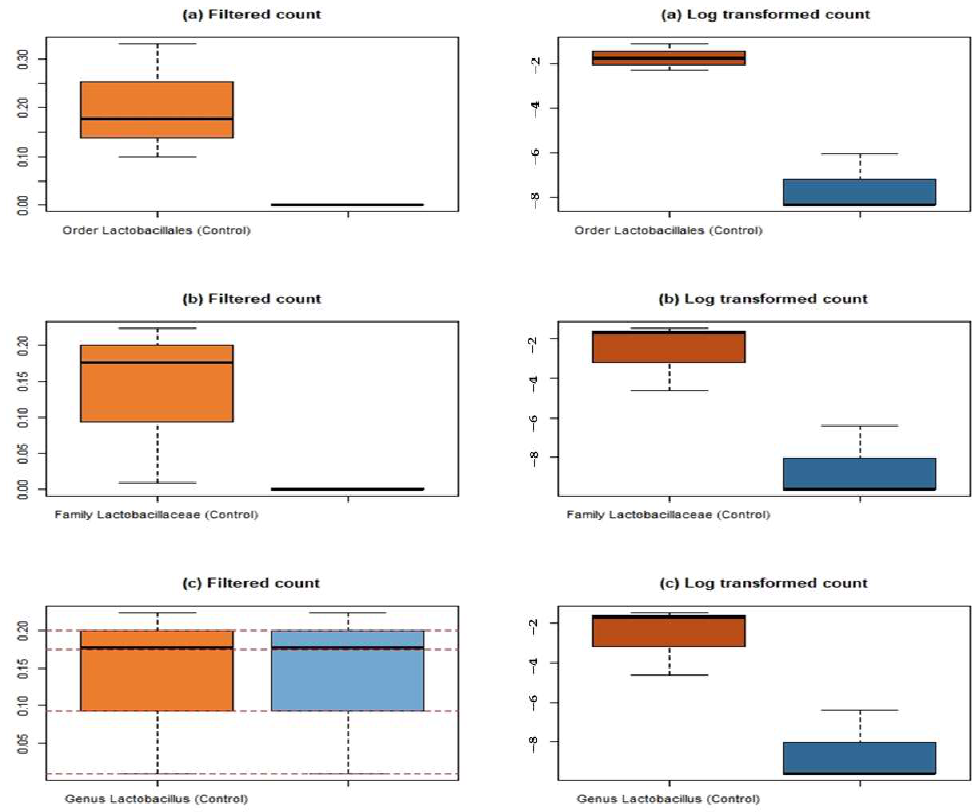
Figure 7. Box plot diagram for comparative count analysis of LAB showing significant variability in control and infected host gut at the taxa level: ( a ) Order Lactobacillales; ( b ) Family Lactobacillaceae; ( c ) Genus Lactobacillus.